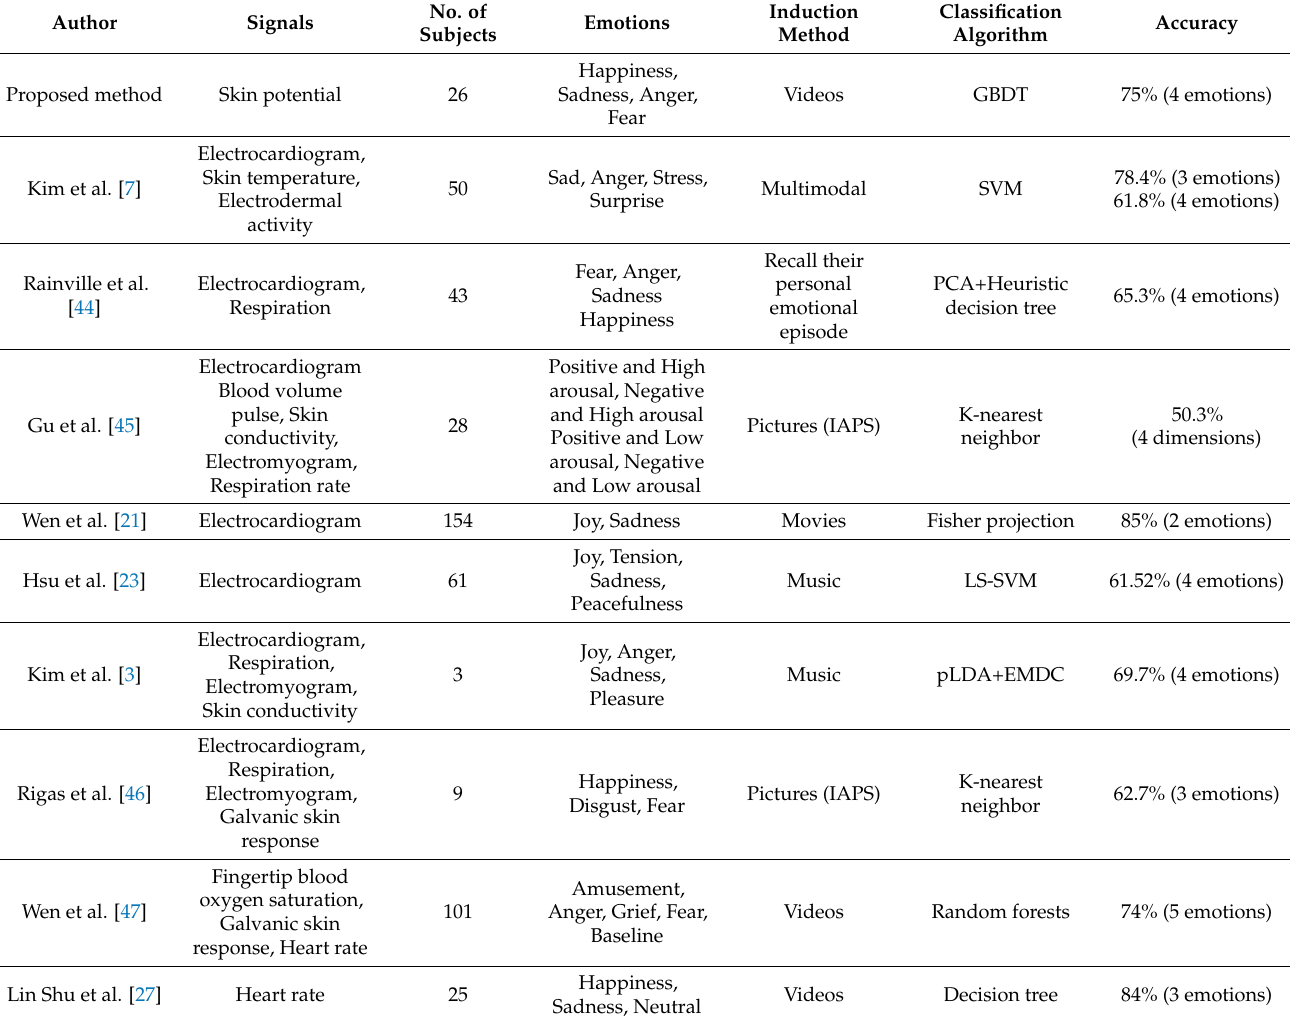
Table 7. Classification Performance Comparisons of Proposed Emotion Recognition Methods with Some Existing Methods for Multi-Emotion Recognition.